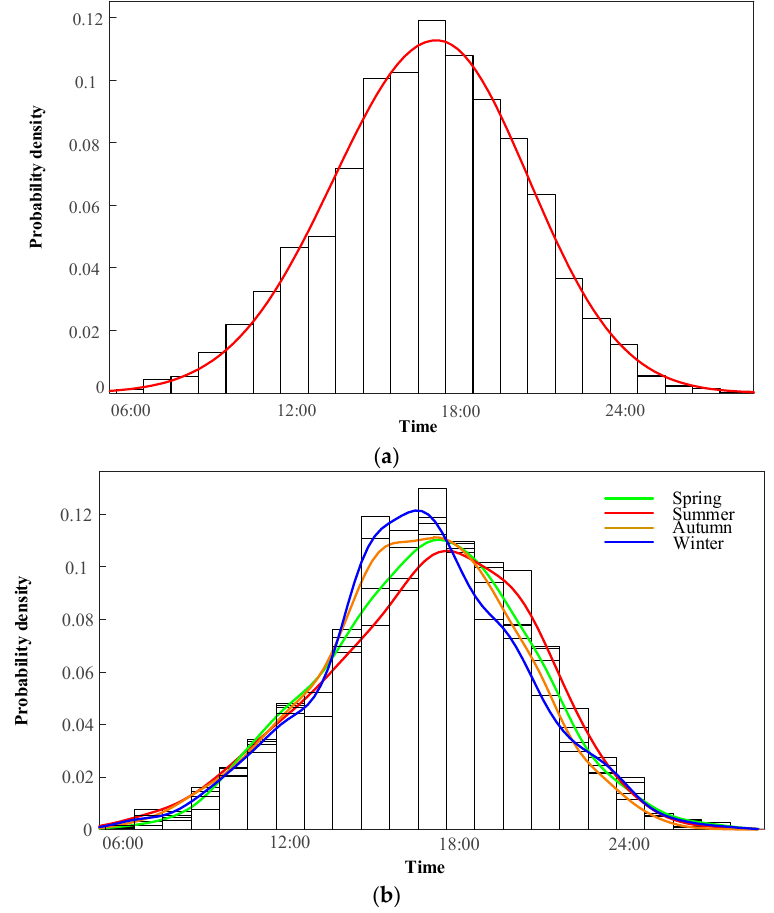
Figure 1. Probability distribution of domestic users’ daily return time from the last trip; ( a ) For one year; ( b ) For different seasons.